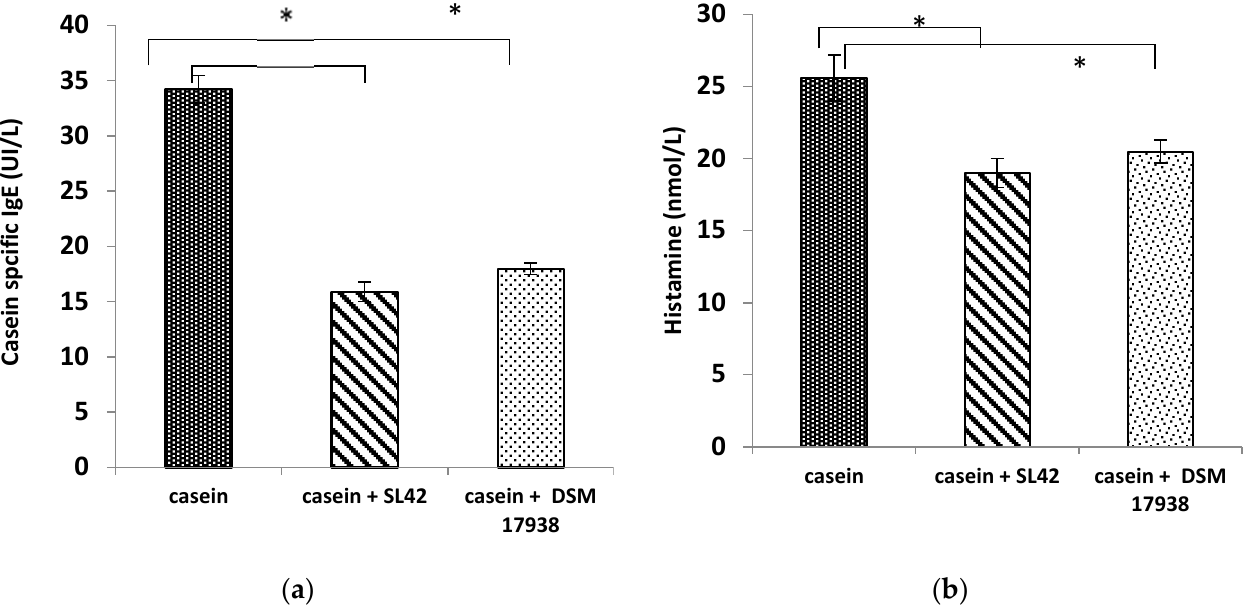
Figure 3. CAS-IgE ( a ) and histamine levels ( b ) in sera assessed using ELISA (n = 8 rats/ group). The data are presented as the mean ± SEM. Statistical analysis was conducted by using one-way ANOVA with Tukey’s multiple comparisons test. * p < 0.05. Casein-sensitized group receiving only casein (casein group), casein-sensitized group treated with SL42 (casein + SL42 group), and casein-sensitized group treated with DSM 17938 strain (casein- + DSM 17938 group).